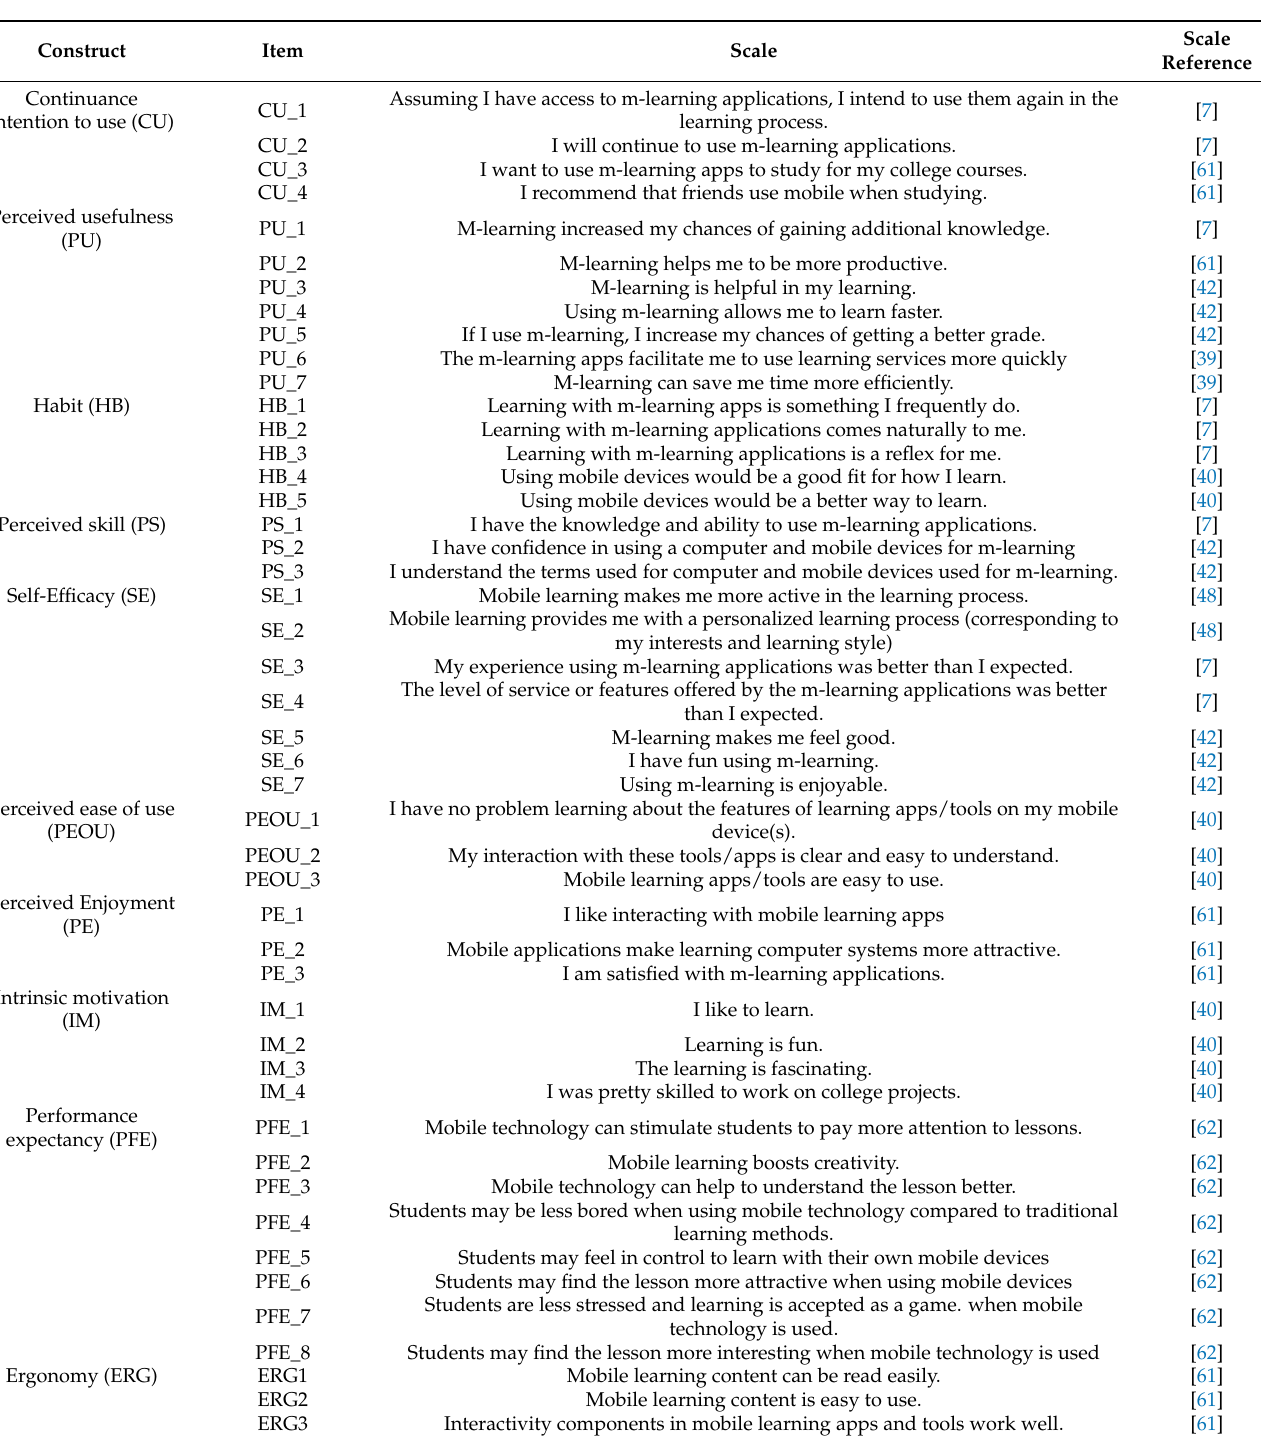
Table A1. Survey